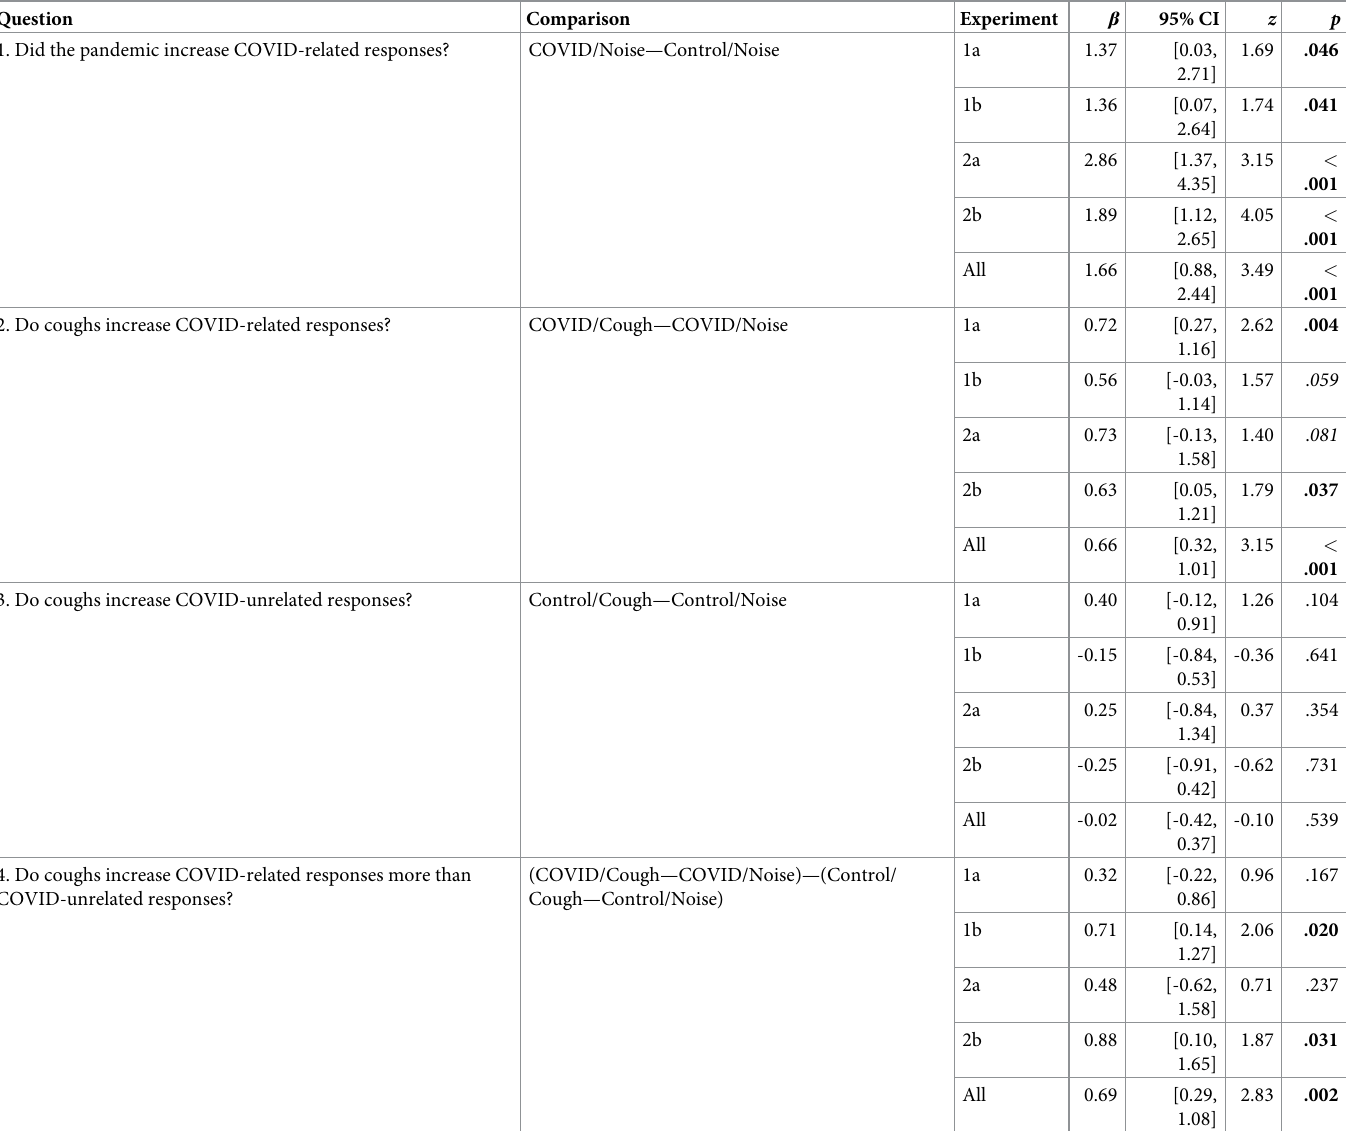
Table 2. Results of all hypothesis tests conducted for individual experiments and across